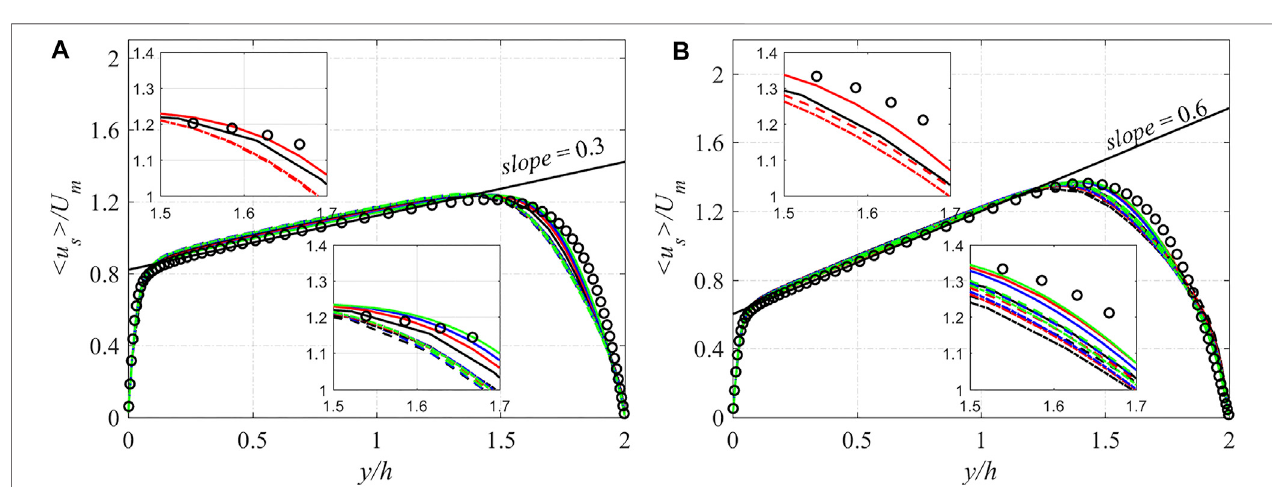
FIGURE 4 | Mean streamwise velocity pro fi les in rotating channel fl ow: (A) Ro = 0.3 and (B) Ro = 0.6.